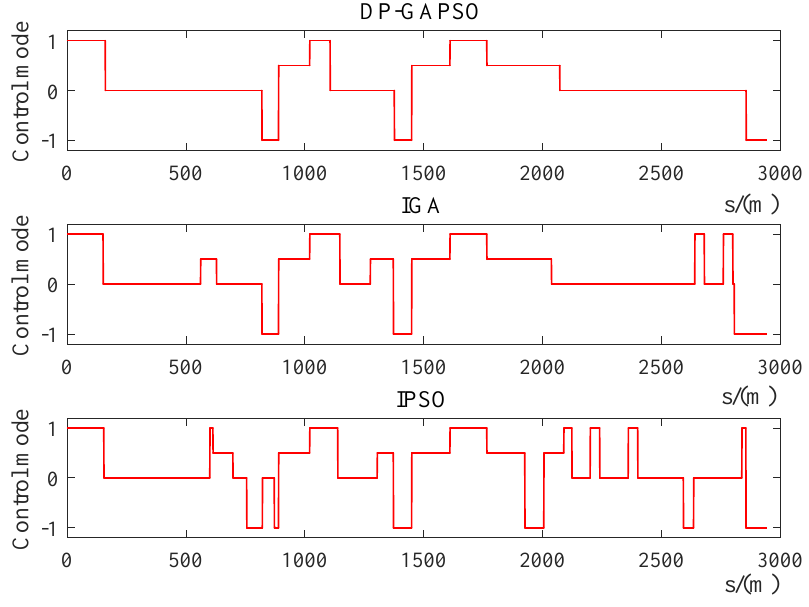
Figure 13. The operating condition distance curve of the train from New Port in Lvshun to Tieshan